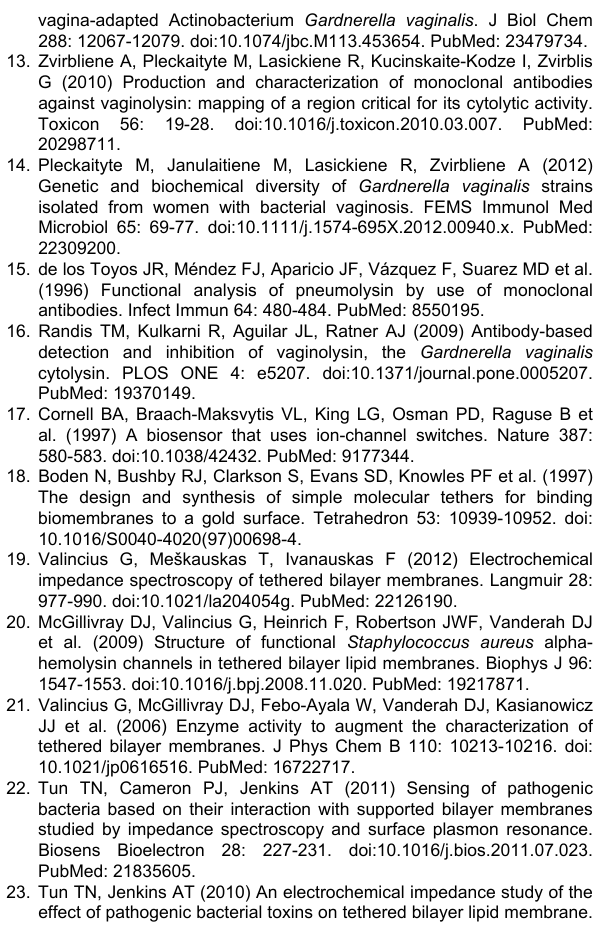
Figure S7. The effect of the MAbs 9B4 and 21A5 on the hemolytic activity of rVLY and its mutant variants. The effect of MAbs 9B4 and 21A5 on the hemolytic activity of rVLY and rVLY mutant variants was tested by addition of human erythrocyte suspension to (A) rVLY (5 ng/mL) pre-incubated with either the neutralizing MAb 9B4 [Pleckaityte et al., 2011] or non-neutralizing MAb 21A5 at concentrations ranging